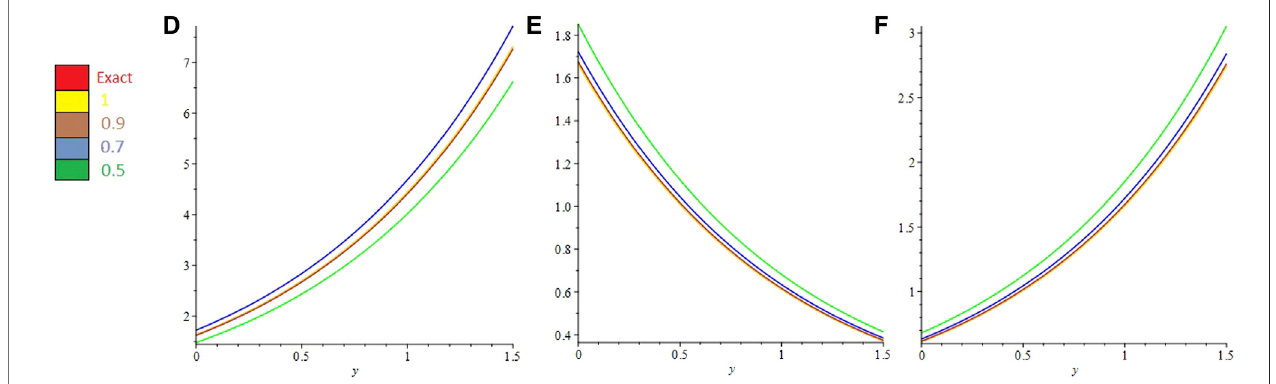
FIGURE 4 | ETDM (D) 2D μ -solution, (E) 2D v-solution, and (F) 2D ω -solution graph respectively at various values of α , β and γ of Problem.